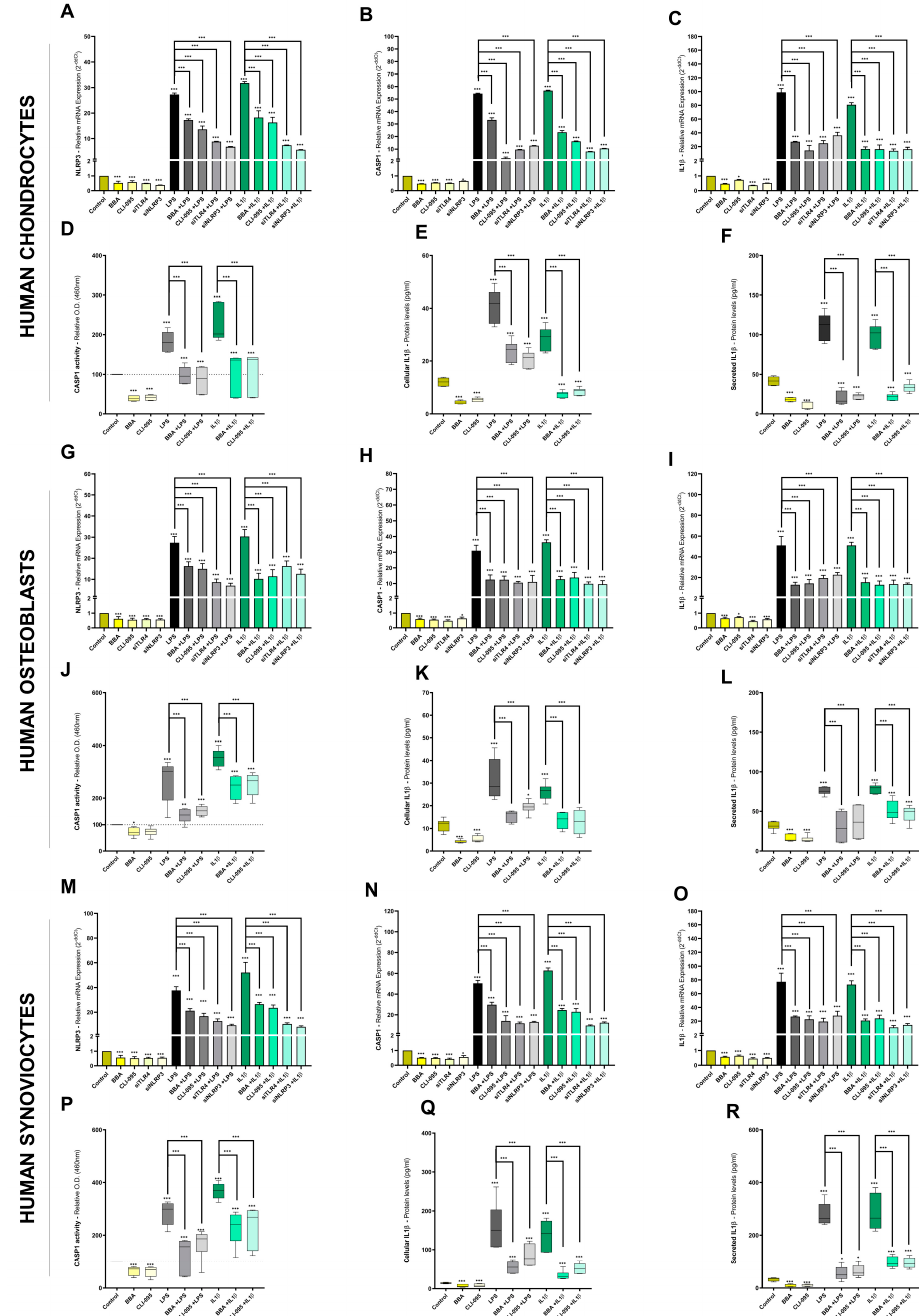
Figure 6. BBA effects on NLRP3-mediated innate immune response in primary joint cells: ( A – R ) Primary human OA chondrocytes (hOC), primary human OA osteoblasts (hOB), and human SW982 synoviocytes (hSW) were treated with BBA (1 µM), CLI-095 (1 µM), siTLR4 (15 nM) and siNRLP3 (15 nM) for 24 h and cotreated with LPS (100 ng/mL) or IL1 β (0.1 ng/mL) for another 48 h. Inde- pendent biological replicas ( n = 6) were normalized (control), expressed as the mean ± SEM, and represented by the statistical significance NEJM system as *** ( p -value < 0.001), ** ( p -value < 0.002), * ( p -value < 0.033); ( A – C , G – I , M – O ) RT-qPCR gene expression (mRNA) of NLRP3, CASP1, and IL1 β in hOC chondrocytes ( A – C ), hOB osteoblasts ( G – I ), and hSW synoviocytes ( M – O ); ( D , J , P ): CASP1 activity (pNA reaction) assay in hOC chondrocytes ( D ), hOB osteoblasts ( J ), and hSW synovio- cytes ( P ); ( E , F , K , L , Q , R ) ELISA of cellular ( E , K , Q ) and secreted ( F , L , R ) IL1 β protein (pg/mL) in hOC chondrocytes ( E , F ), hOB osteoblasts ( K , L ) and hSW synoviocytes ( Q , R